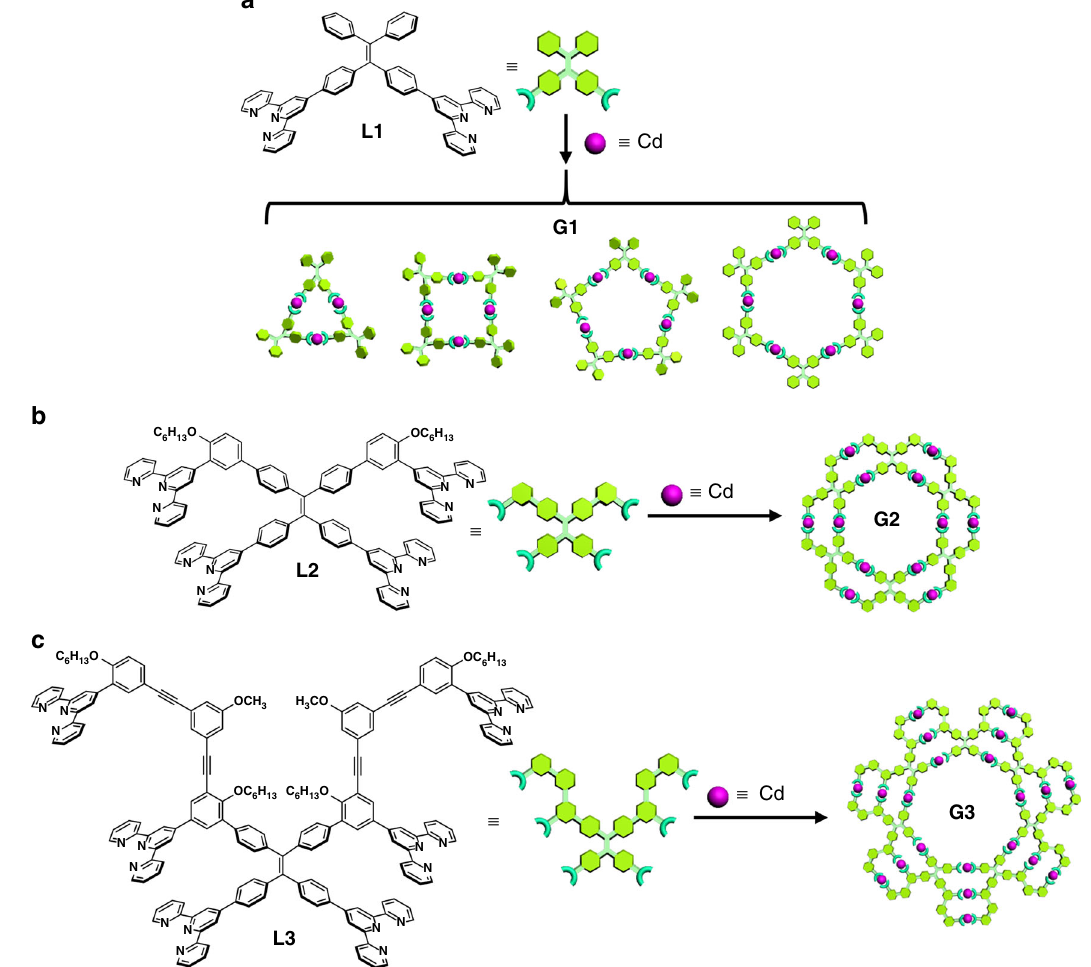
Fig. 1 Self-assembly of supramolecular rosettes G1 − G3 . a L1 assembled with Cd 2+ to form a mixture of trimer, tetramer, pentamer, and hexamer macrocycles ( G1) ; b L2 assembled with Cd 2+ to form a discrete hexamer ( G2 ); c L3 assembled with Cd 2+ to form a discrete heptamer (